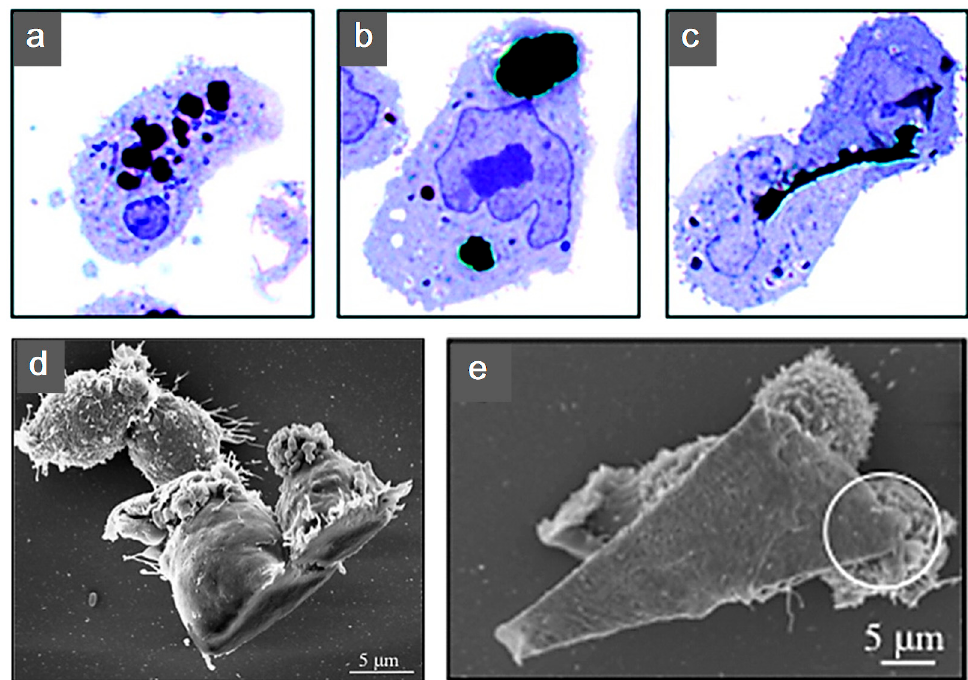
Figure 10. Human THP-1 macrophages internalization of few-layered graphene (FLG). Untreated cells were exposed to ( a ) 550 nm, ( b ) 800 nm and ( c ) 5 μ m FLG sizes. For interaction to become more apparent under light microscopy, cells were stained with blue. ( d , e ) Macrophage interaction with FLG [140]. Reproduced with permission from Sanchez et al., Chemical Research in Toxicology , published by American Chemical Society, 2011.